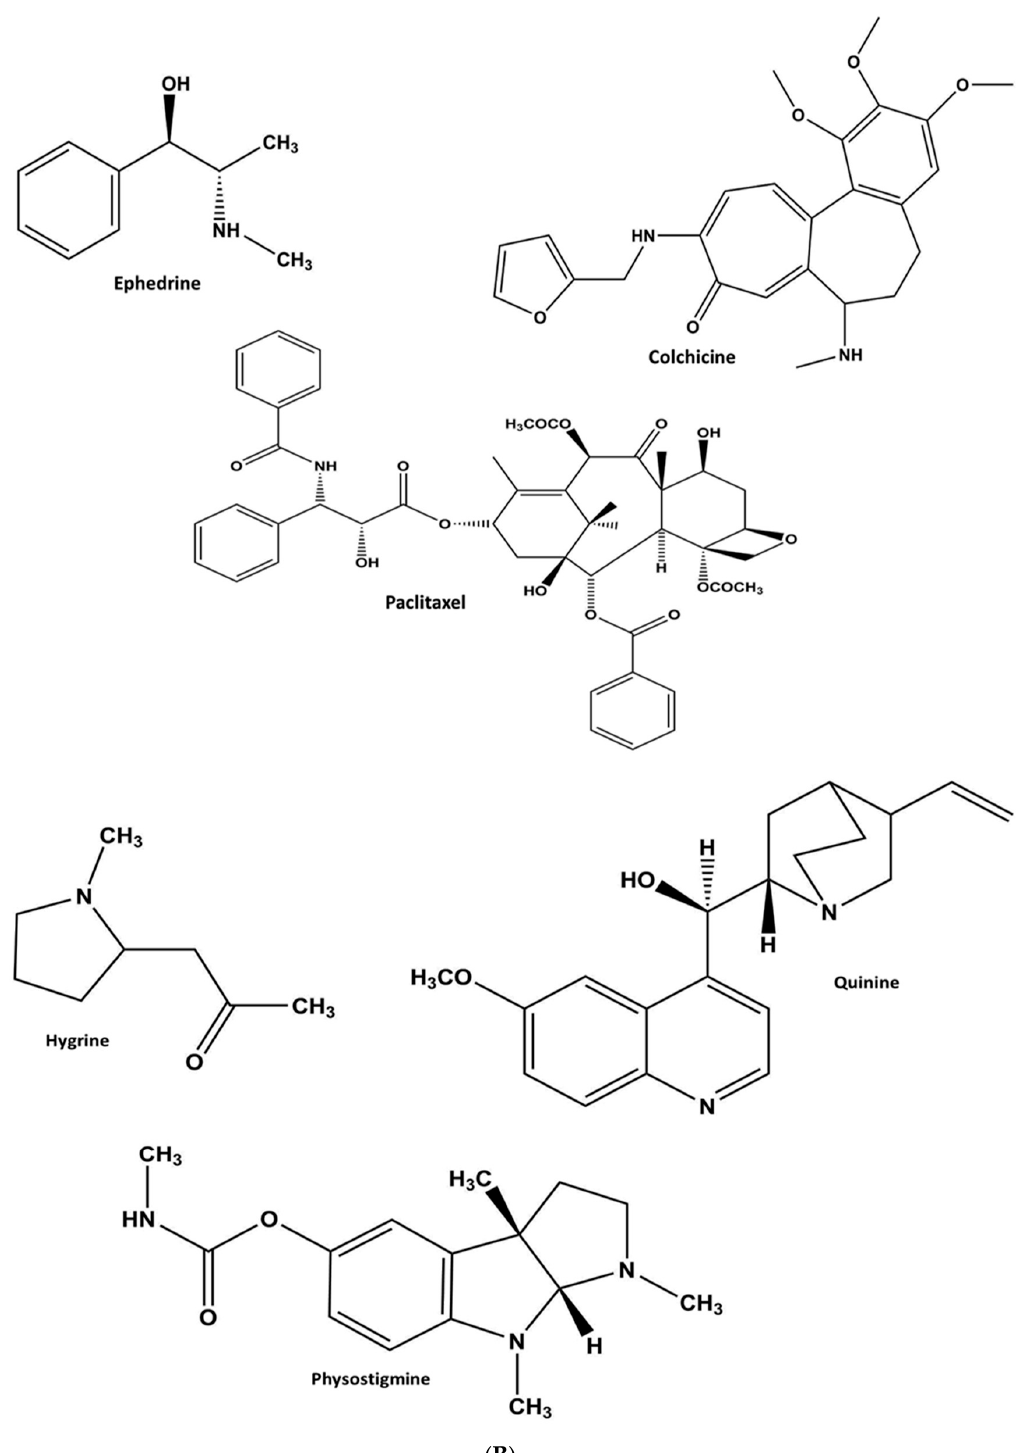
Figure 3. ( A ) Alkaloids and their types, Common structure of ( B ) Heterocyclic alkaloids and Non- heterocyclic alkaloids. Non-heterocyclic